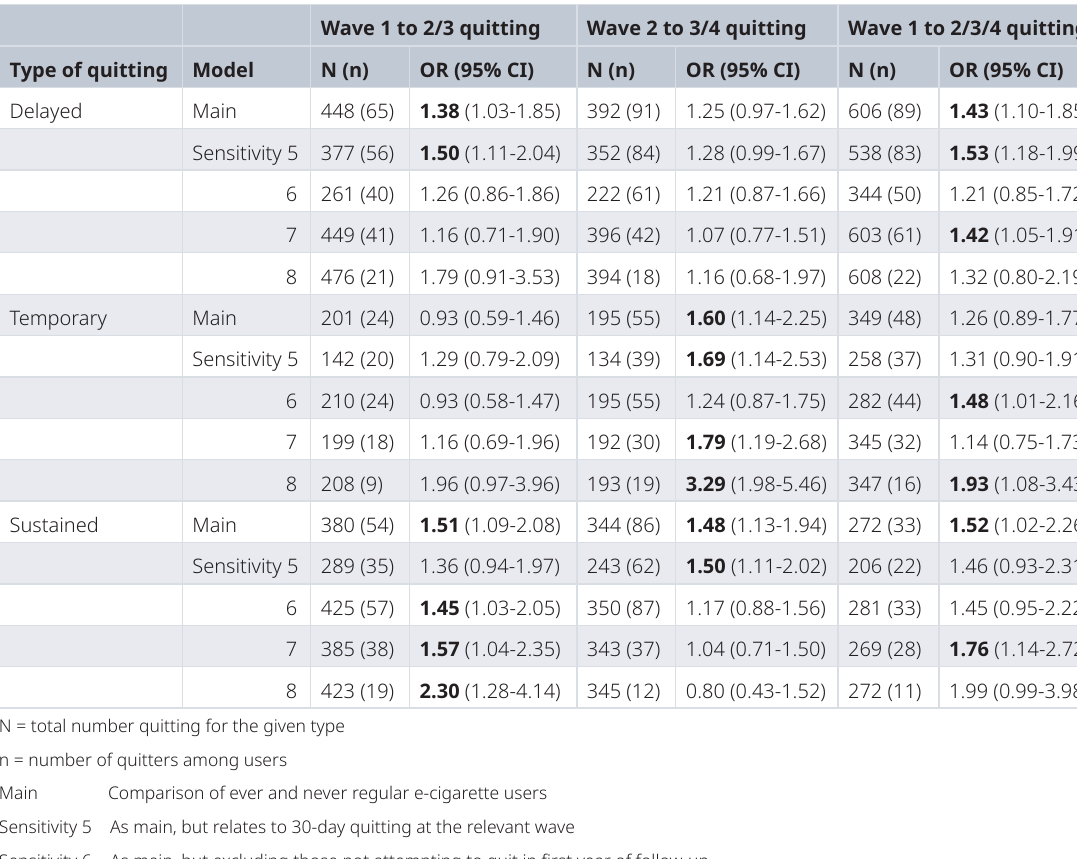
Table 7. Comparing adjusted ORs for the effect of e-cigarette, smokeless tobacco or snus use on quitting in the main and sensitivity